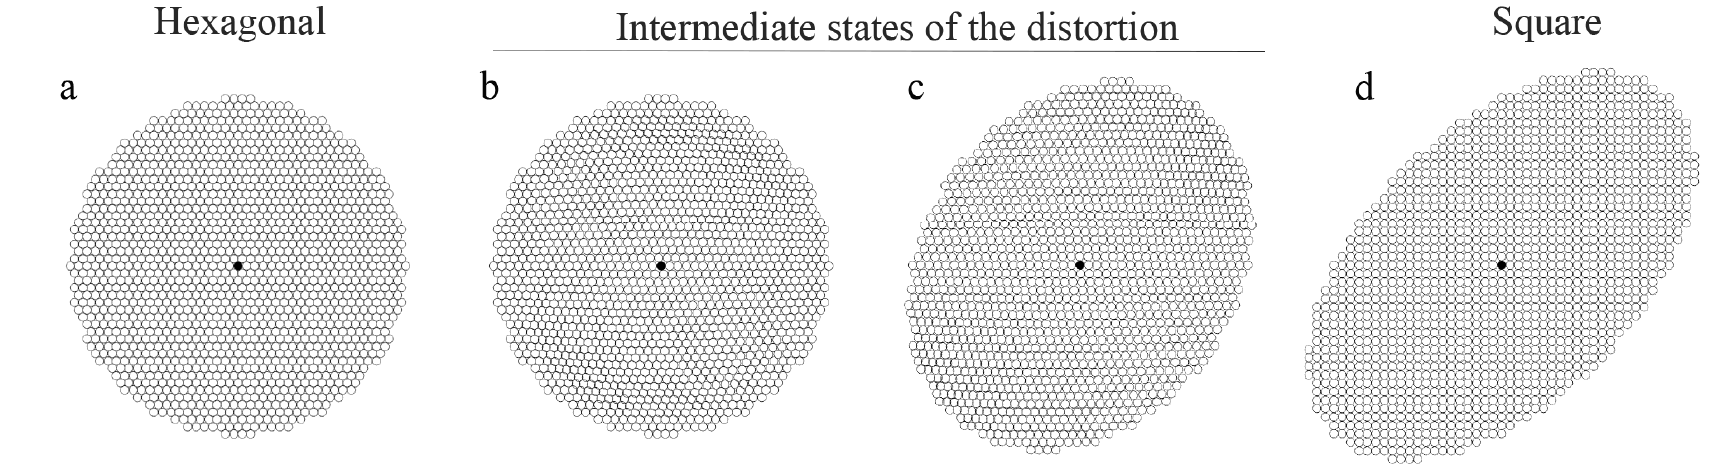
Figure 36. Quasi-elastic lattice distortion during the (hexagonal ⟶ square) transformation of a free crystal. ( a ) Initial parent hexagonal phase, ( b , c ) intermediate states of the formation of the daughter square lattice inside the parent hexagonal lattice (the retained parent hexagonal phase can be identified close to the surface), and ( d ) daughter square phase after complete transformation. The initial circular shape of the crystal became elliptic after transformation. There is no “twinning dislocation” involved in the mechanism.